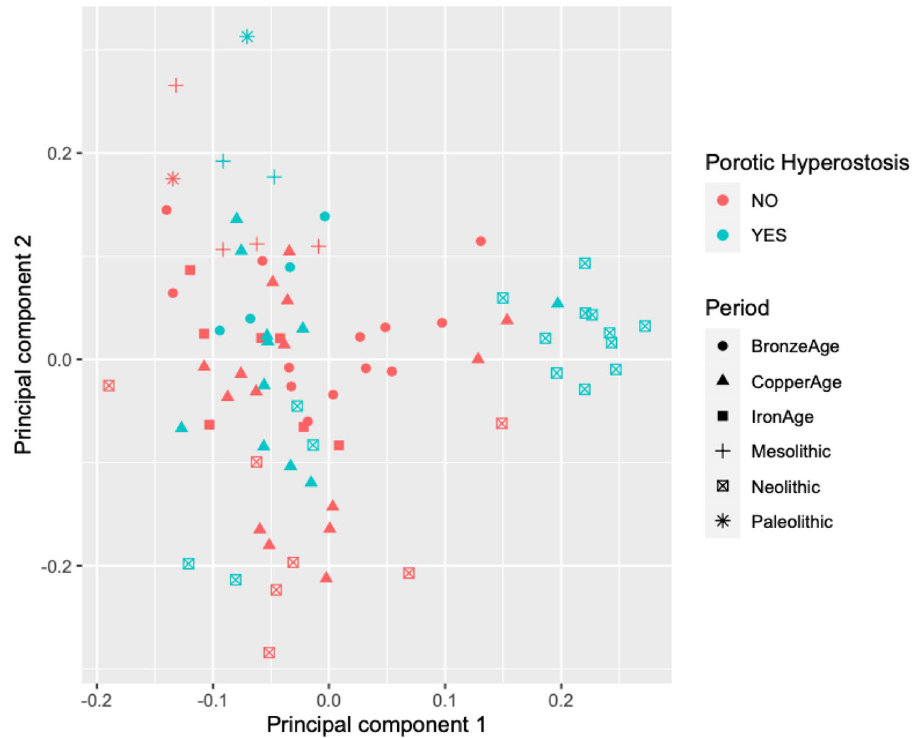
Figure 4. PCA for the 80 ancient individuals tested here using 772,964 SNPs. Each dot represents an individual. In red are marked individuals that were not affected with PH. In green are shown individuals that had PH. The different shapes represent different periods, encompassing from the Palaeolithic to the Bronze Age. The PCA was calculated with PLINK.